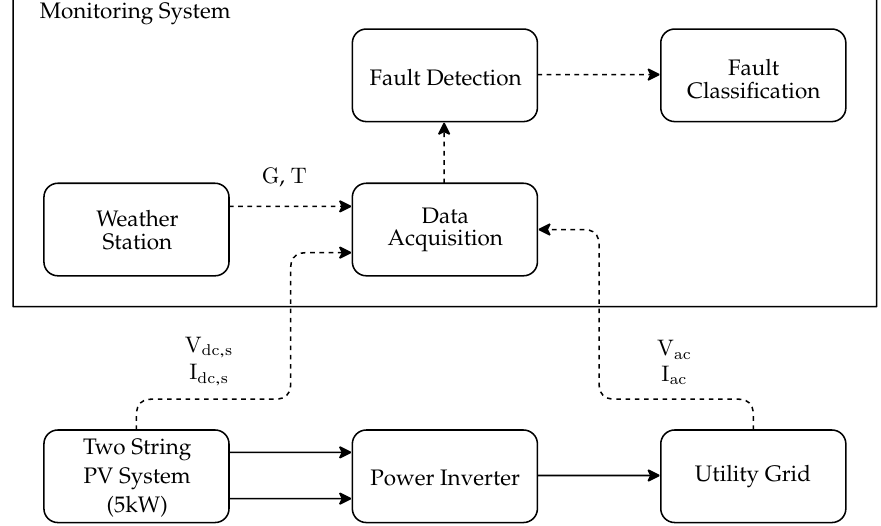
Figure 1. General Overview of the System Figure 1: The proposed method consists in transmitting a frame using ⌈ α n cha ⌉ channel uses for the fi rst trans- mission attempt, with 0 < α ≤ 1 . In the event of a decoding error, incremental redundancy is transmitted 1 − α n cha ⌋ channel uses. making use of the rest of the available ⌊ ( )